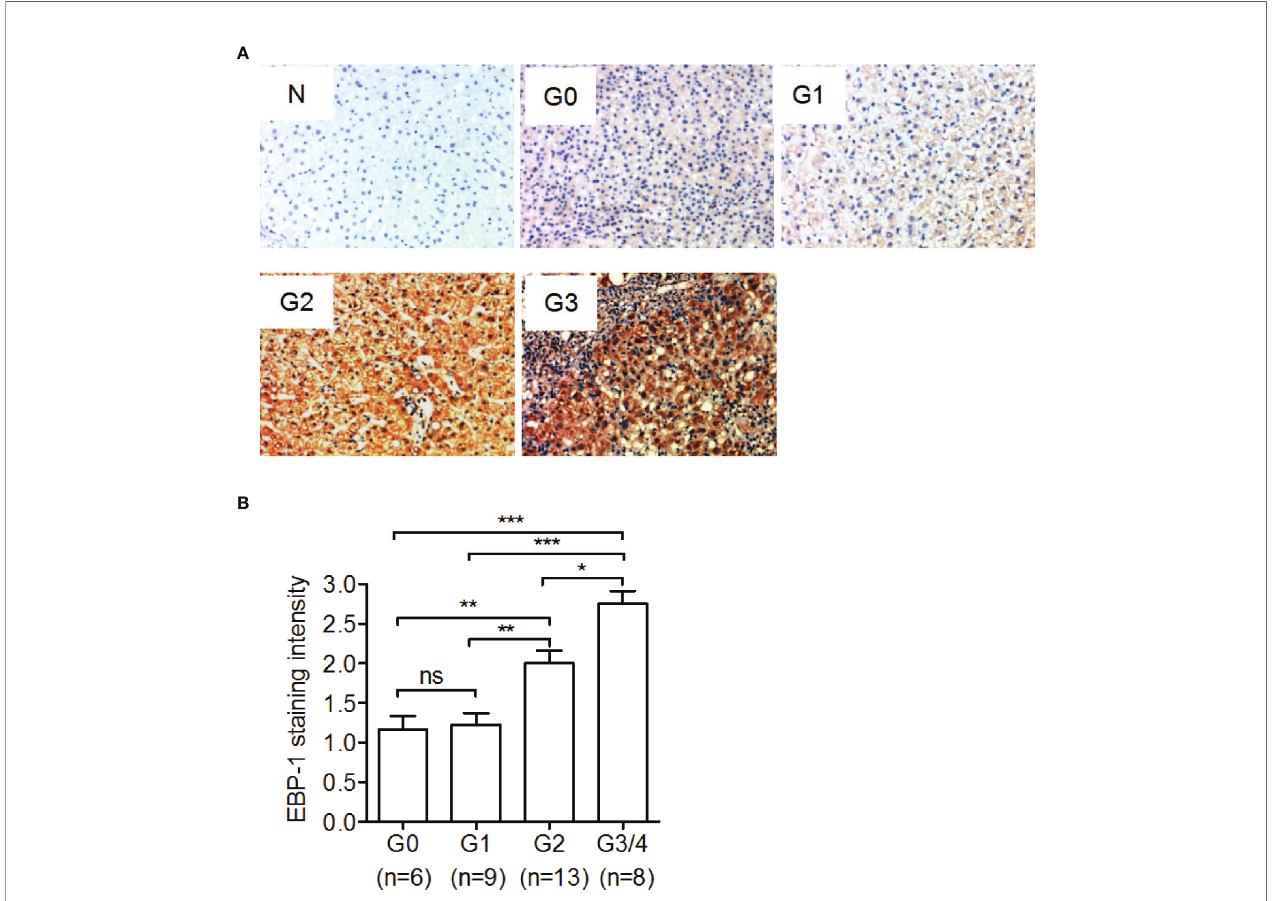
FIGURE 2 | Immunohistochemical staining of ErbB-3-binding protein-1 (EBP-1) in liver tissue samples from CHB patients. A total of 36 CHB patients underwent liver biopsy, and immunohistochemical staining was performed to detect EBP-1 expression in the liver tissue samples. Hepatic in fl ammation was graded as G0, G1, G2, and G3-G4 using the modi fi ed histological activity index. (A) Representative images of immunohistochemical staining of EBP-1 in liver tissue samples with different histological grades. The intensity of EBP-1 staining in liver tissue incubated with normal rabbit IgG (1:200) was used as a negative control (N). Magni fi cation 200 ×. (B) The intensity of EBP-1 was scored as follows: 0 = negative, 1 = weak, 2 = moderate, and 3 = strong. The EBP-1 staining scores were compared among CHB patients with different in fl ammatory grades. Signi fi cance was determined by Kruskal-Wallis test followed by Dunn ’ s Multiple Comparison Test; ns, non- signi fi cant; * P < 0.05; ** P < 0.01; *** P <